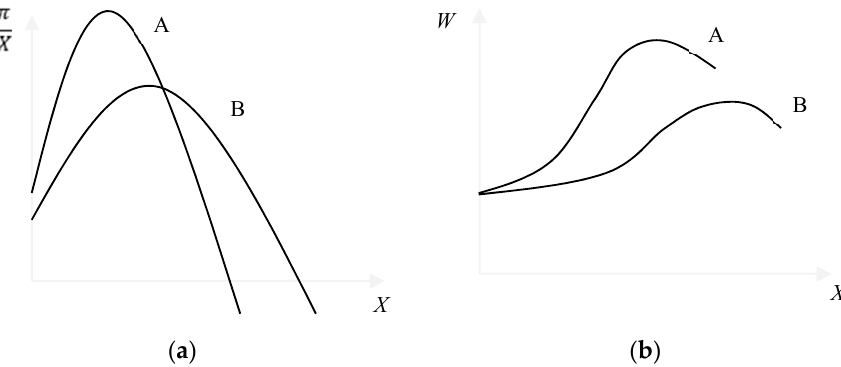
Figure 2. Marginal income of A and B in subfigure ( a ) and wealth of A and B in subfigure ( b ). The resources in poor regions are relatively scarce. Consider an extreme case where